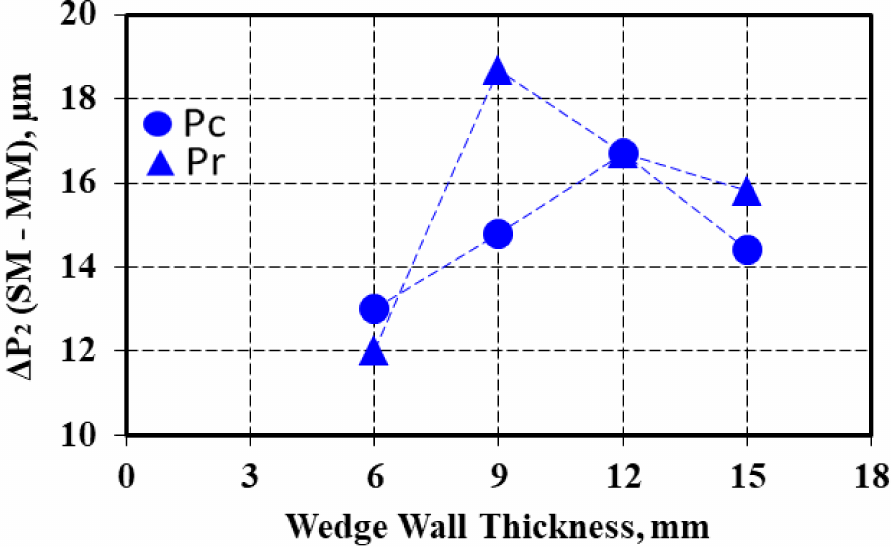
Figure 8. Influence of the wedge casting wall thickness on the difference between the graphite perimeter values ( ∆ P 2 ) in the sand and metal mold solidification.